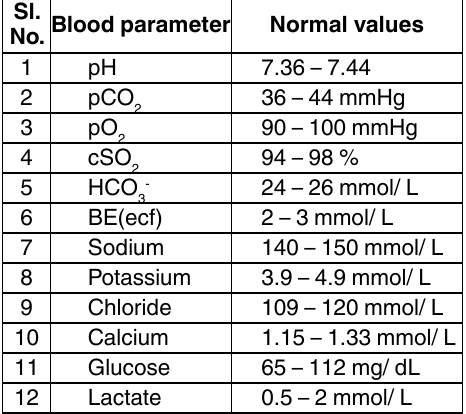
table 1. Reference range for various blood gases, electrolytes and metabolites in dogs sl. Blood No.